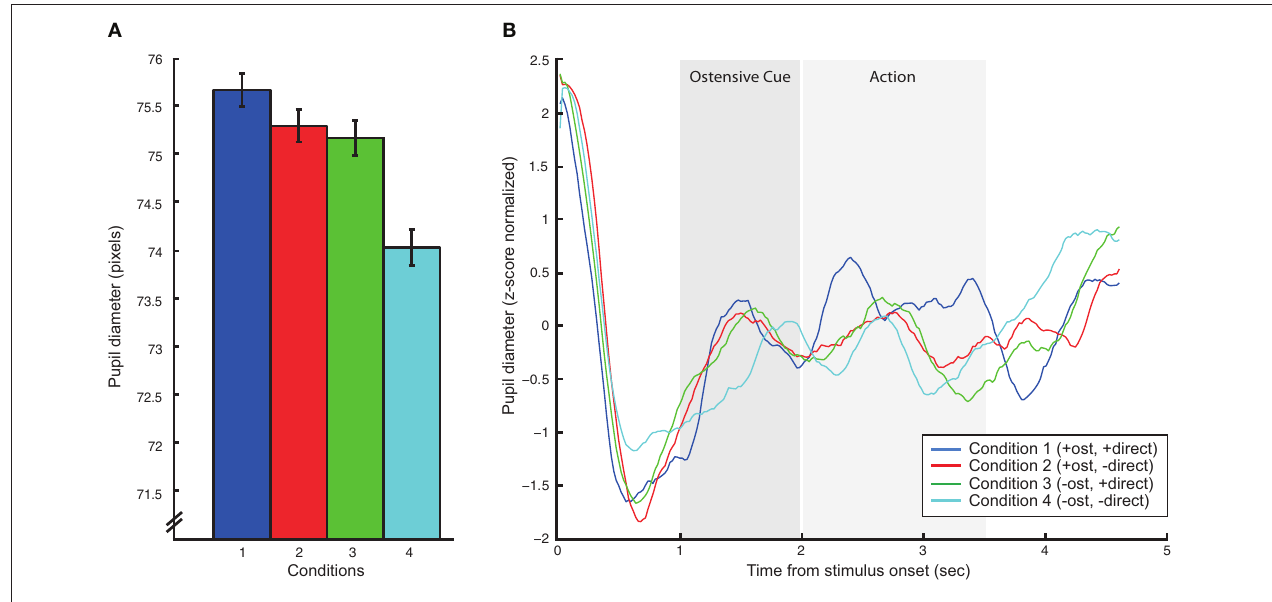
FIGURE 3 | Results of the pupillometric analysis. (A) Summarizes mean pupil dilations in pixels for each of the four action conditions (we here omit the no-action conditions to simplify the graph since that main effect of action was not significant). Error bars express standard error of the mean.